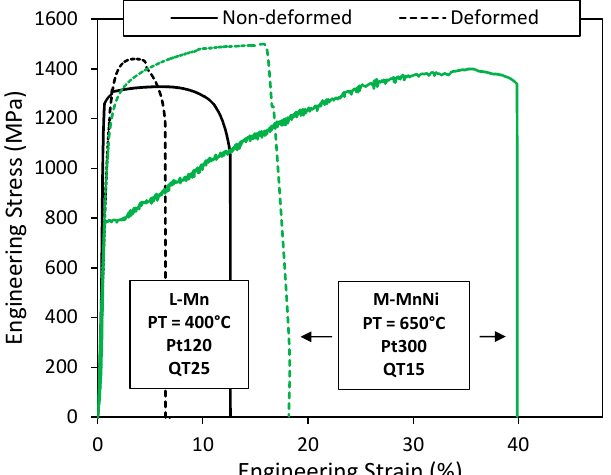
Figure 11. Engineering stress–strain curves after cold forming Q&P sheets of L-Mn steel (QT25/PT = 400 °C/Pt = 120 s) and of M-MnNi steel (QT15/PT = 650 °C/Pt = 300 s). The curves obtained in the non-deformed and deformed areas of the Omega part are compared.